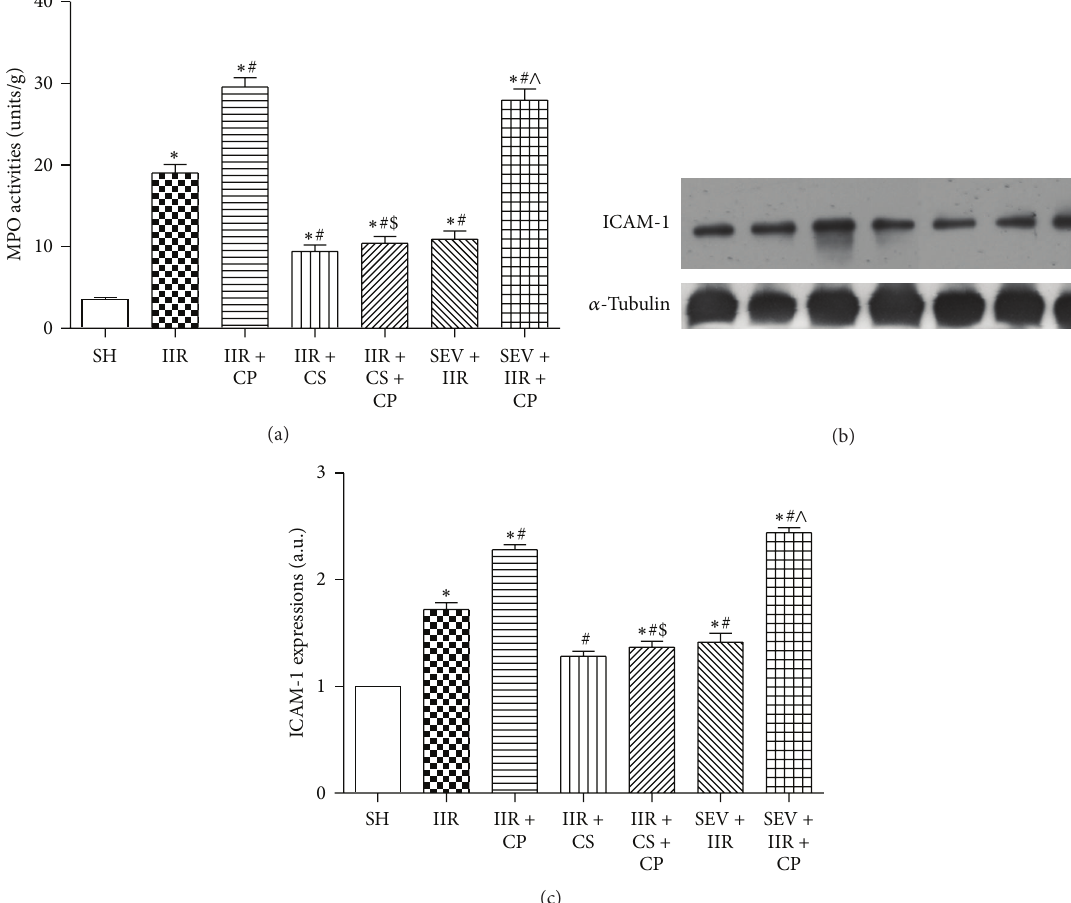
Figure 4: MPO activities and ICAM-1 protein expression in intestine mucosa after IIR injury. SH group (Sham-operated group), IIR group (75 minintestinalischemiaand2 hreperfusion),IIR+CPgroup(IIRgroup+Compound48/801mg/kg),IIR+CSgroup(50mg/kgcromolyn sodiumtreatedIIRgroup),IIR+CS+CPgroup(50mg/kgcromolynsodiumtreatedIIRgroup+Compound48/801mg/kg),SEV+IIRgroup (2.3% sevoflurane pretreated IIR group), and SEV + IIR + CP group (2.3% sevoflurane pretreated IIR group + Compound 48/80 1mg/kg). Bar graph (a) quantified MPO activities in intestinal mucosa ( 𝑛 = 6 ). Representative band of ICAM-1 protein expressions is displayed in (b). Bar graphs (c) quantified ICAM-1 protein expressions ( 𝑛 = 3 ). Results are expressed as Mean ± SEM. ∗ 𝑃 < 0.05 versus SH group, # 𝑃 < 0.05 versus IIR group, $ 𝑃 < 0.05 versus IIR + CP group, & 𝑃 < 0.05 versus IIR + CS group, and ∧ 𝑃 < 0.05 versus SEV + IIR